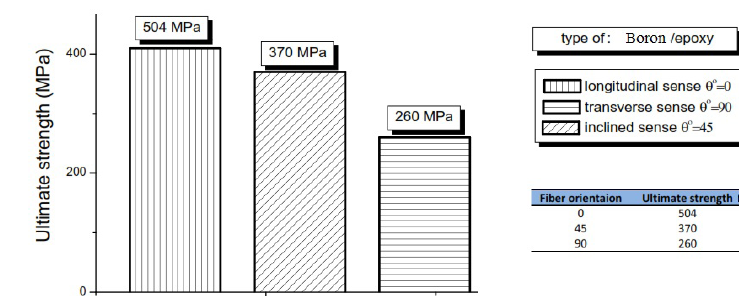
Figure 4. Ultimate strength depending on the fibers orientation of graphite/epoxy.